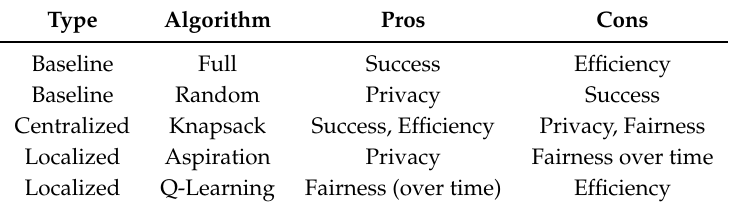
Table 5. Summary of advantages and disadvantages of contribution